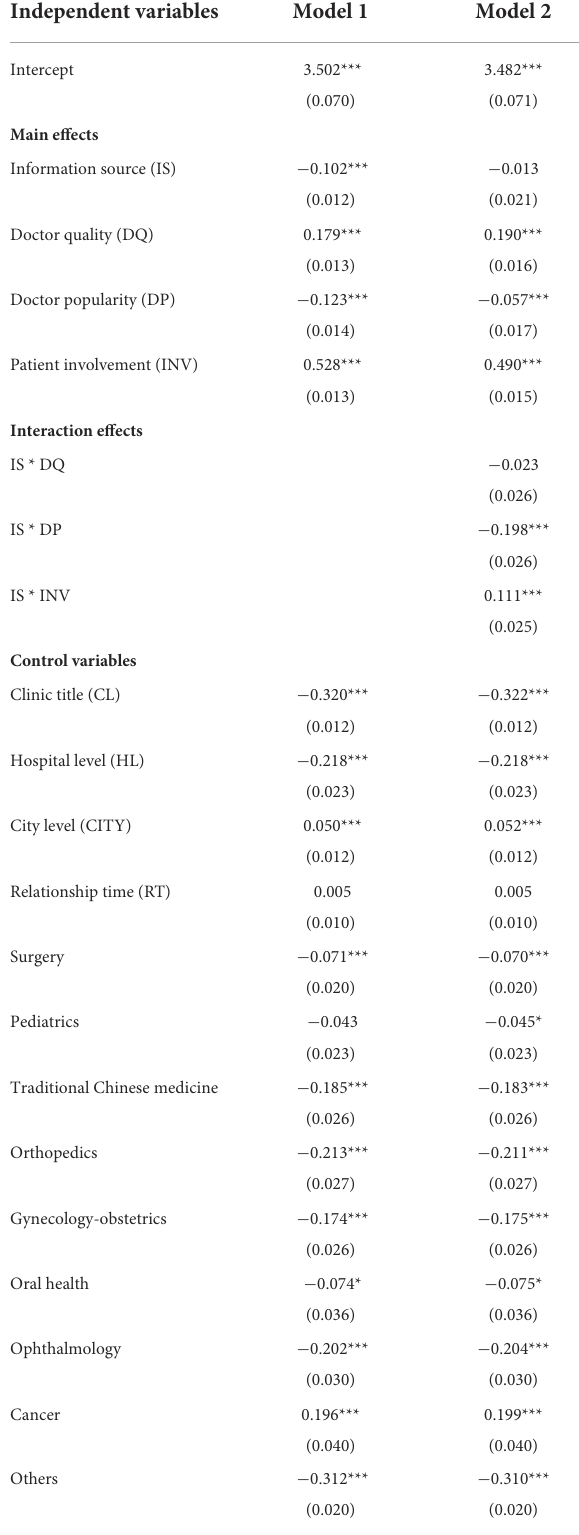
TABLE 5 Results for the effects of determinants on service attitude